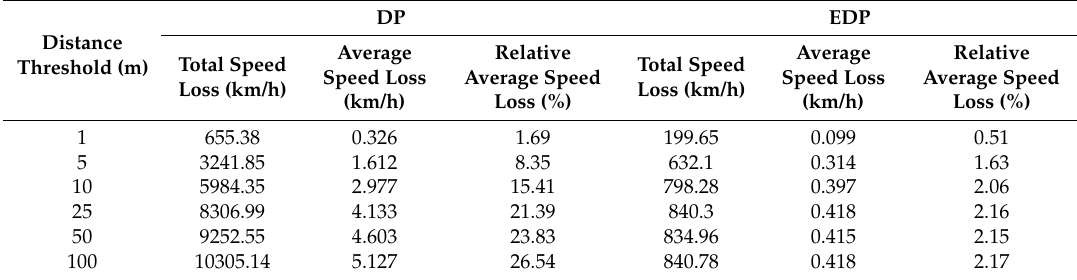
Table 4. Speed loss of DP and EDP simplification on Dataset 2 with different distance thresholds.